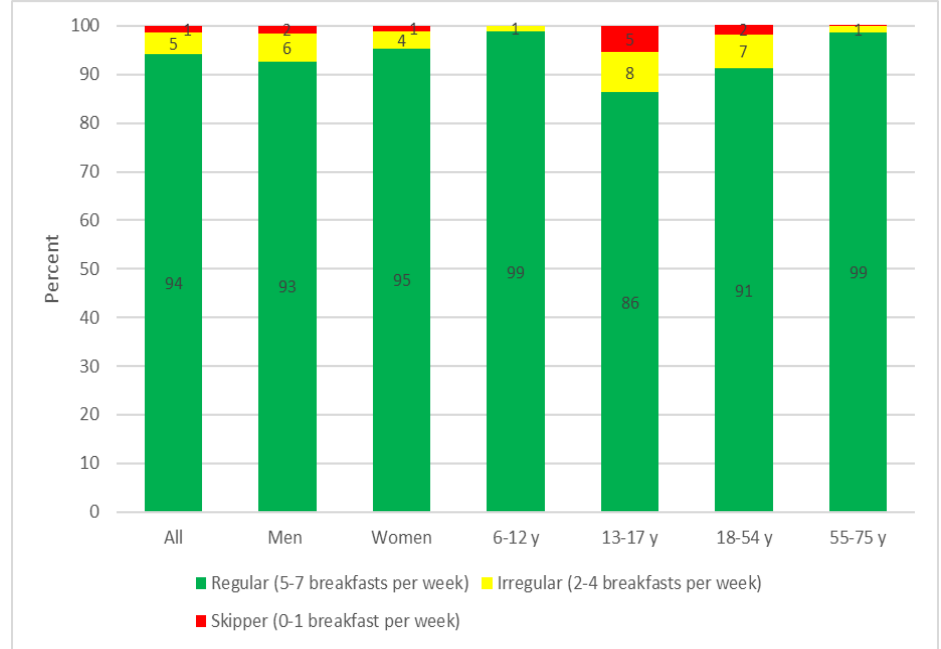
Figure 1. The proportion of skippers, irregular consumers, and regular consumers in the total Danish population according to gender and age ( n = 3680).